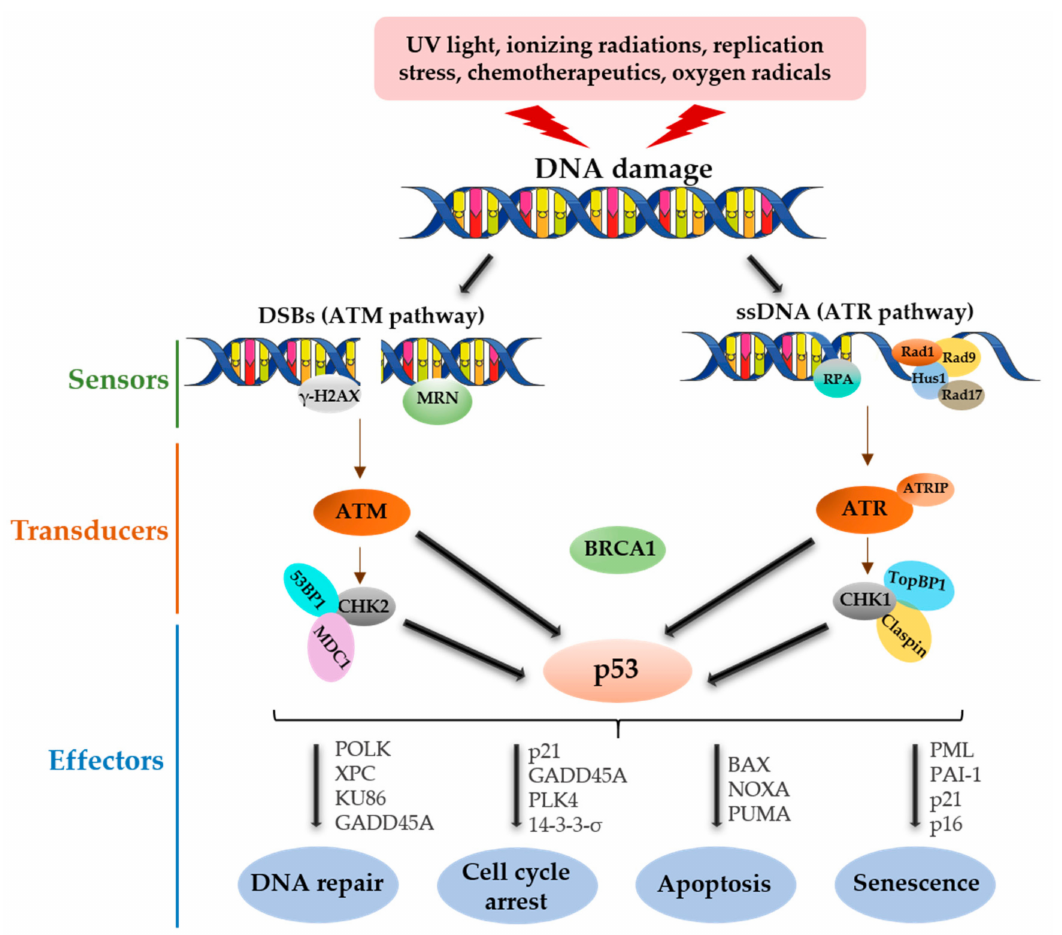
Figure 1. Overview of the DDR and p53 functional roles. Upon DNA damage, the damage sensor proteins sense the DNA lesions, recruit and activate the cascade of transducers, which, in turn, activate the DNA damage effectors that exert an appropriate response to fix the damage and maintain the genome integrity. Double-stranded DNA breaks (DSBs) are sensed by the MRN complex and fixed by the ATM/DNA-PK kinase-mediated response pathway. Single-stranded breaks (ssDNA) are sensed by the RPA and RAD complex, which activates the ATR kinase-mediated response. BRCA1—Breast cancer type